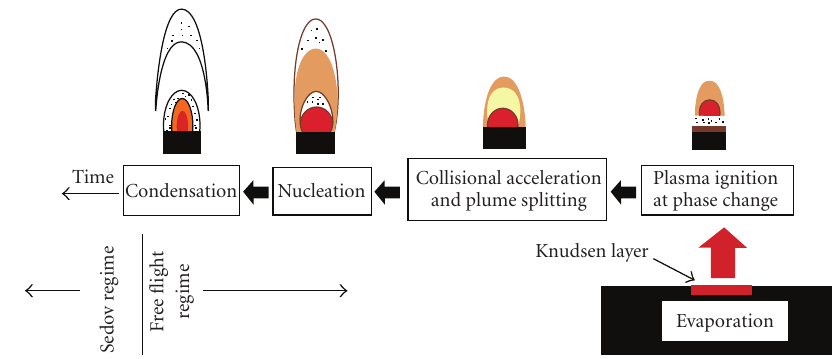
Figure 5: Time evolution of a femtosecond plume.